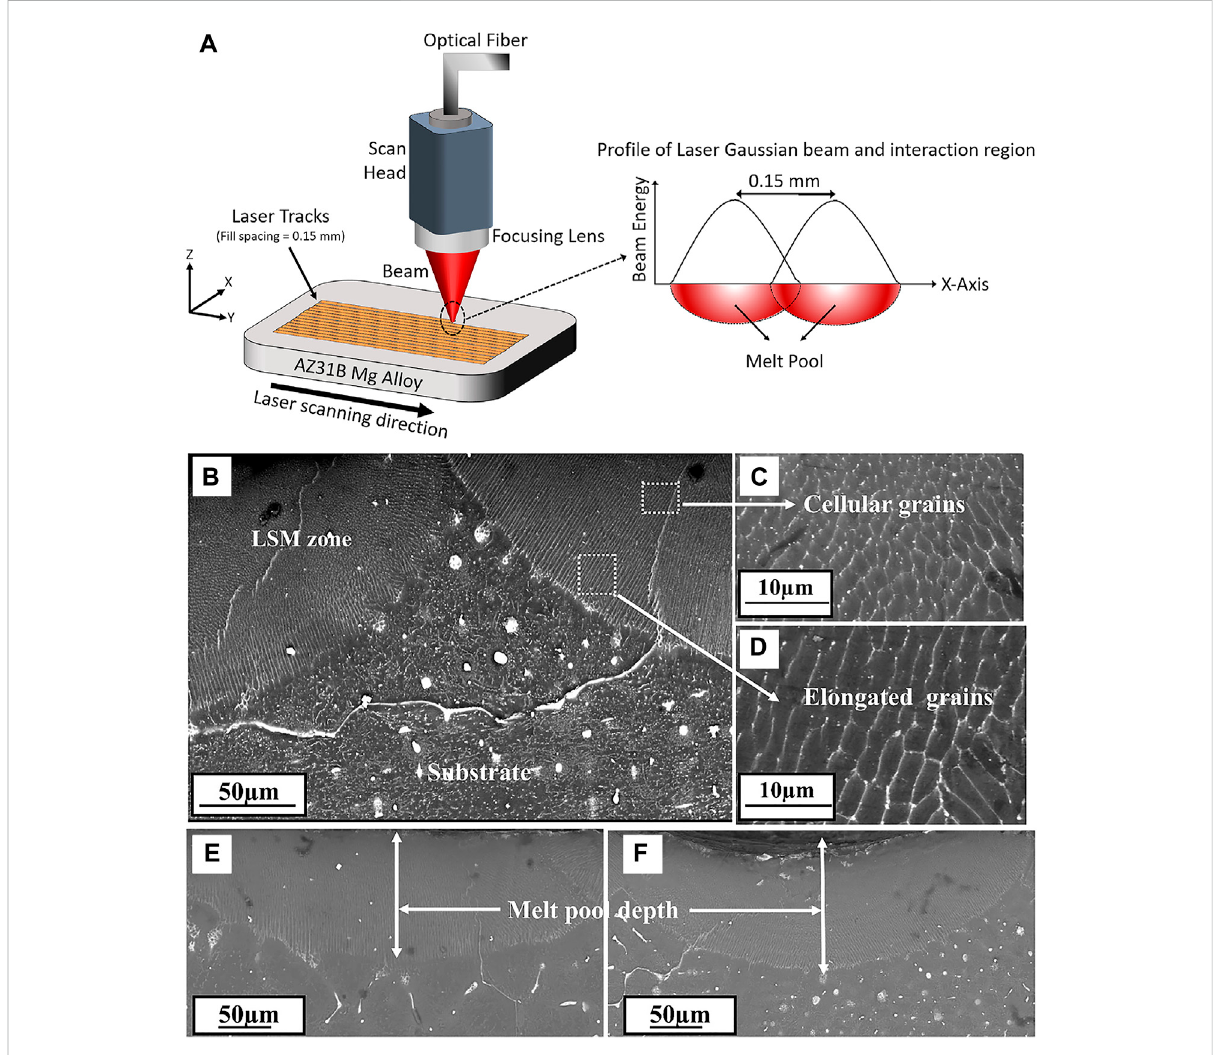
FIGURE 10 (A) Schematic of laser surface modi fi cation process; SEM images of cross section microstructure (B) laser melted Mg-Zn-Dy alloy, (C) and (D) enlarged views, (E) and (F) meltpool depth of the alloy processed at different conditions respectively. Reprinted with permission from reference (Rakesh et al., 2019),